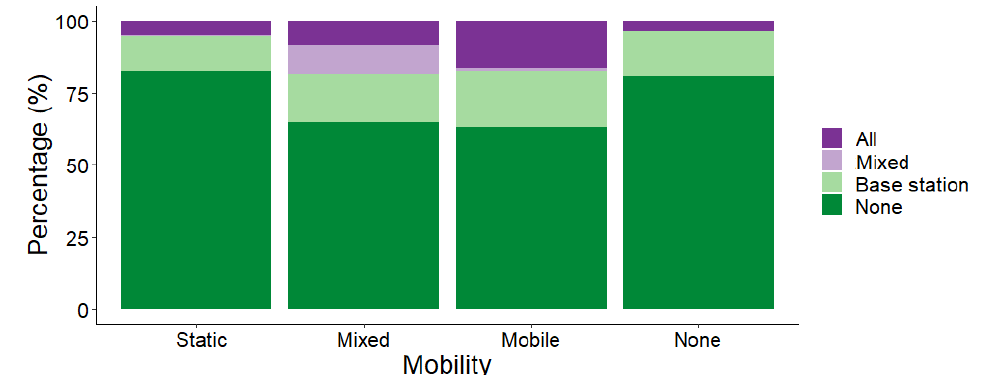
Figure 27. Deployment distribution between node mobility and usage of rich nodes.